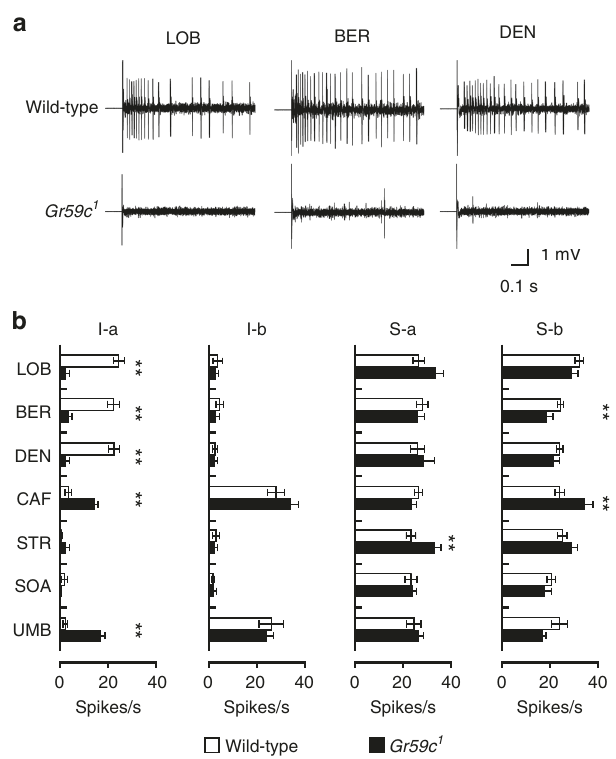
Fig. 2 Electrophysiological responses of Gr59c 1 mutant sensilla to bitter chemicals. a Representative traces from I5 sensilla from wild-type and Gr59c 1 fl ies upon application of 1 mM stimulations with the indicated chemicals. b Mean responses of the indicated sensilla in wild-type and Gr59c 1 fl ies to 1 mM stimuli of the indicated bitter compounds except 5 mM CAF. n = 6 – 50. Unpaired Student t -tests or Mann − Whitney U -tests as appropriate. All data are presented as means ± S.E.M. ** p <